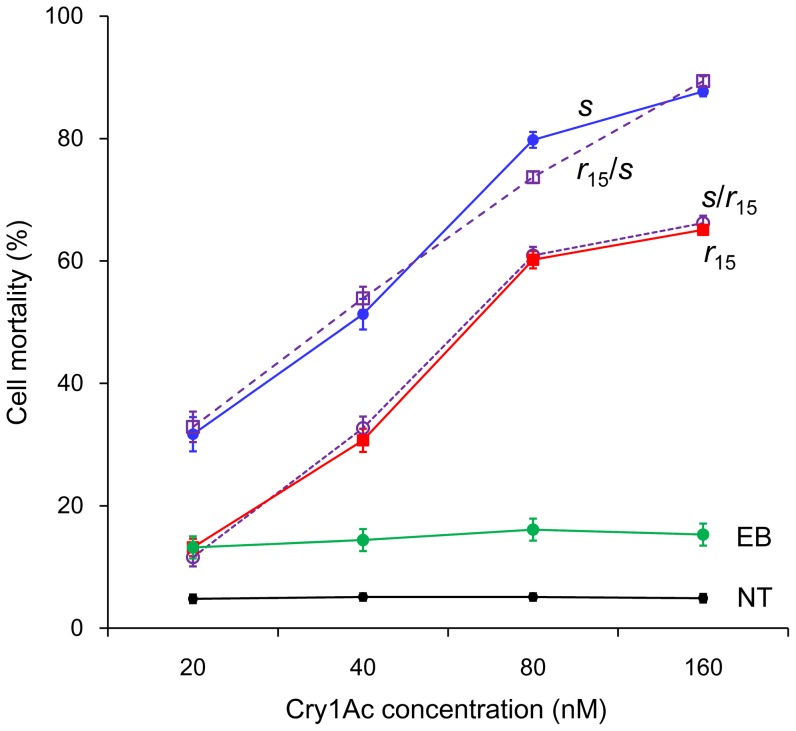
Mortality of Sf9 cells exposed to Cry1Ac.Sf9 cells were transfected with one of four alleles of HaCad (s, r
15, r
15
/s, and s/r
15; see Figures 4 and S2 for details) or an empty bacmid (EB), or were not transfected (NT). For cells transfected with alleles of HaCad, LC50 values (95% FL) were significantly higher for alleles with the cytoplasmic domain of r
15 (r
15: 85 [71–110] and s/r
15: 82 [68–100]) than for alleles with the cytoplasmic domain of s (s: 38 [31–46] or r
15
/s: 38 [31–45]). LC50 values did not differ significantly between Sf9 cells transfected with alleles of HaCad that had the same cytoplasmic domain (r
15 and s/r
15; s and r
15
/s).